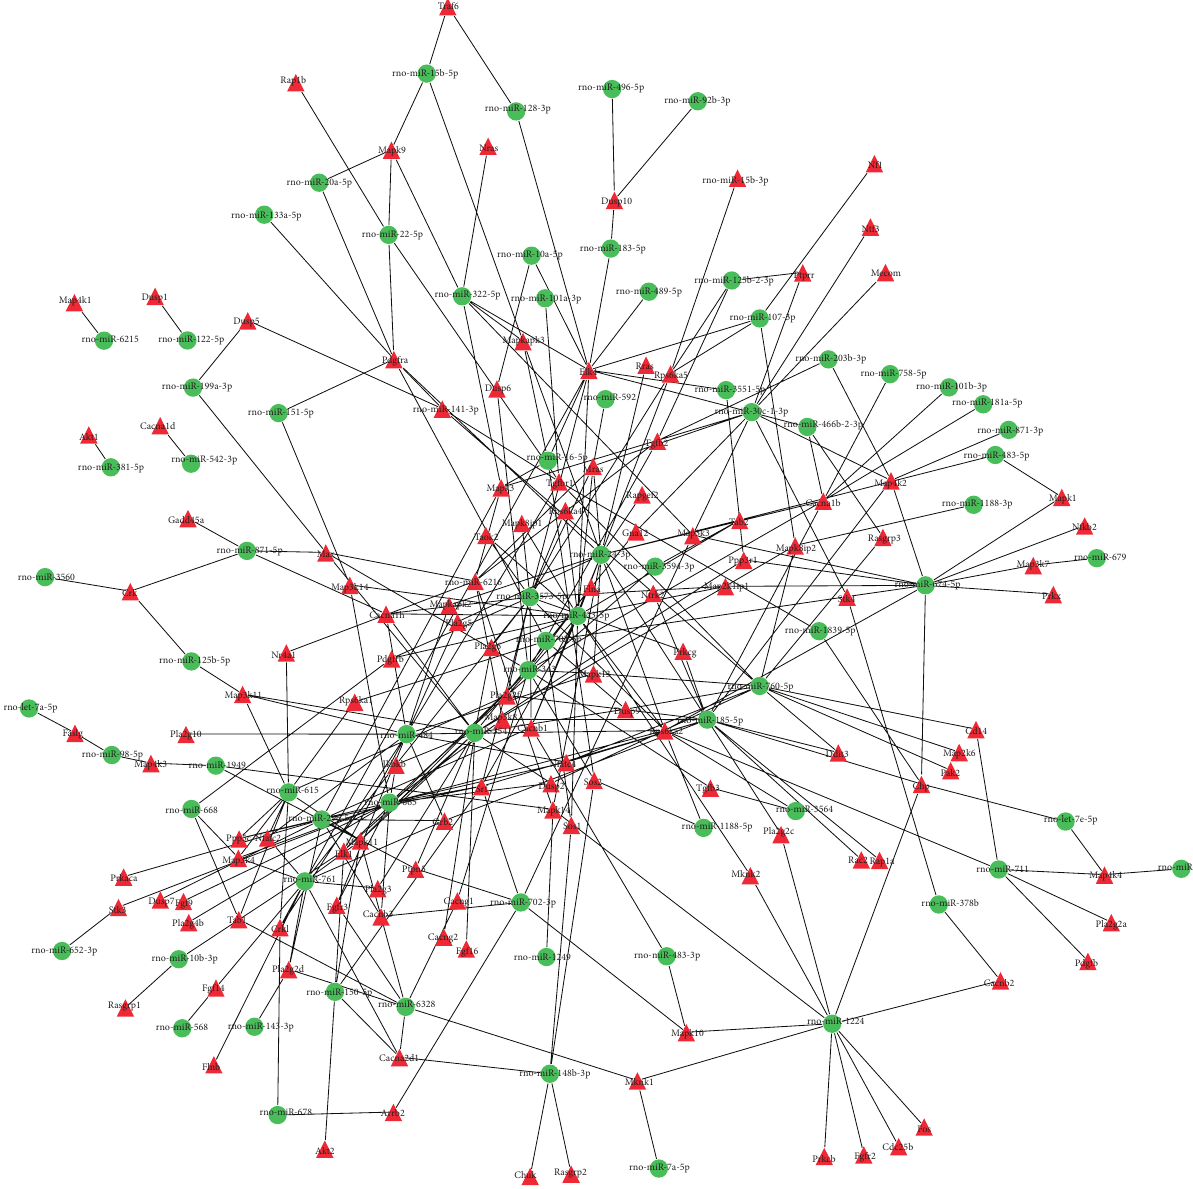
Figure 4: Interaction network of differentially expressed miRNAs and their regulated target genes. Green ellipse shape nodes refer to differentially expressed miRNA, and red triangle shape nodes refer to their regulated target